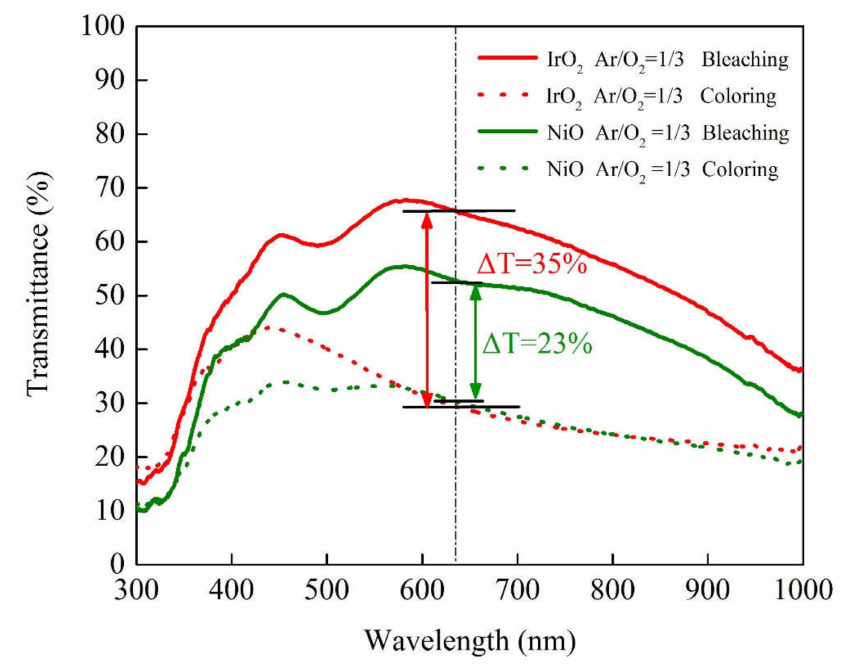
Figure 7. The optical transmittance spectra showing coloring and bleaching comparison states of the IrO 2 and NiO electrodes with Ar/O 2 = 1/3 in the range from 300 nm to 1000 nm.